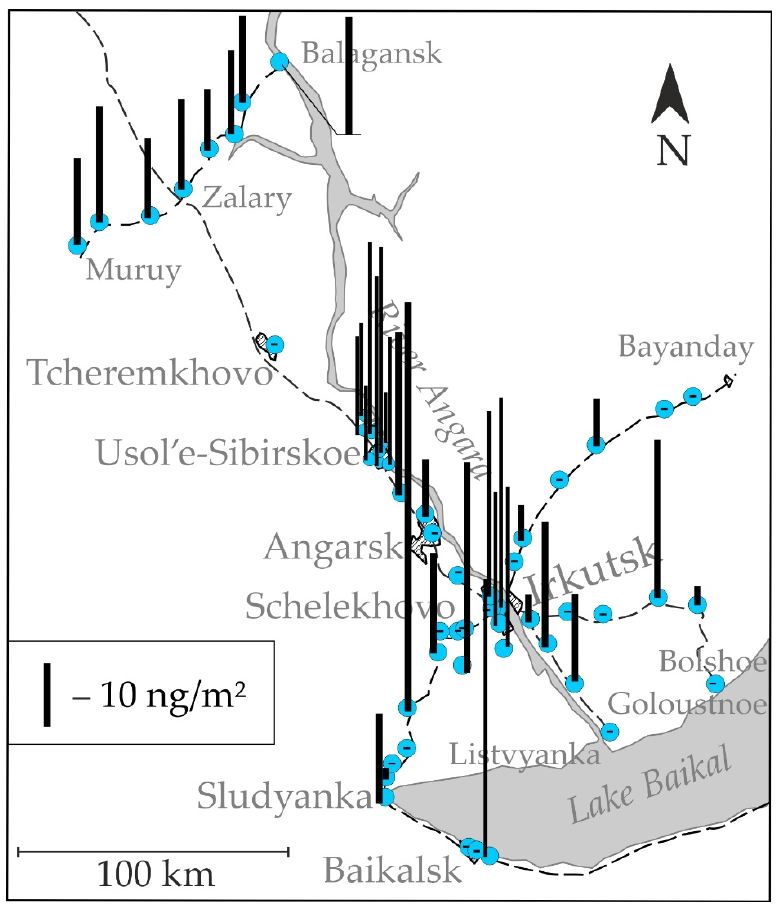
Figure 6. PCB-11 in snow in the southern part of Irkutsk Region in 2021 (ng/m 2 ). In this study, the spatial distribution of PCB-11 in snow was irregular. The highest PCB-11 levels were found at one sampling site along the road from Irkutsk to Sludyanka, followed by the levels at several sites in Irkutsk and Usol’e-Sibirskoe and near the town